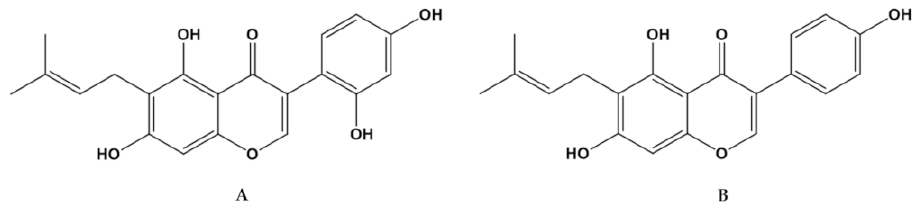
Figure 1. Chemical structures of ( A ) FL ( A ) and ( B)